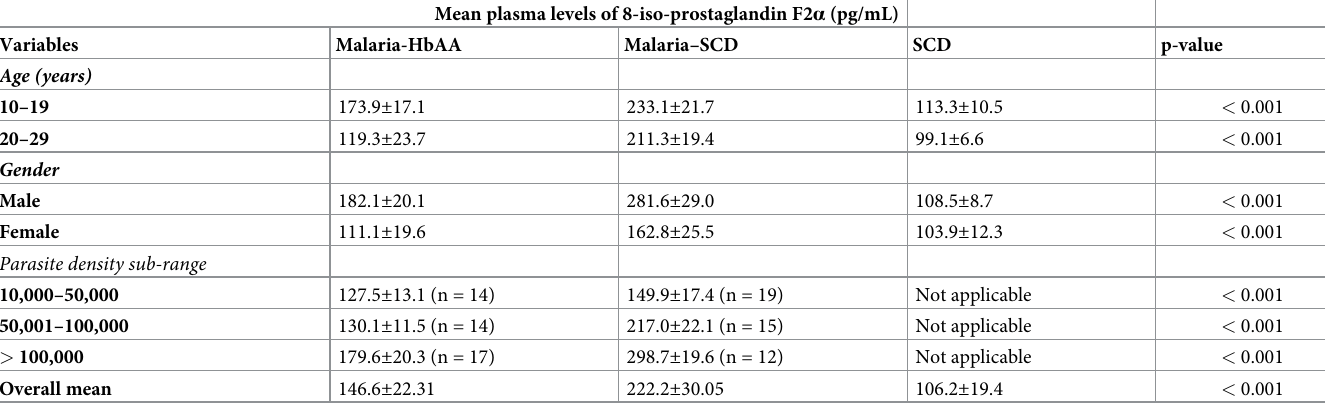
Table 2. Analysis of 8-iso-prostaglandin F2 α levels in malaria and SCD.